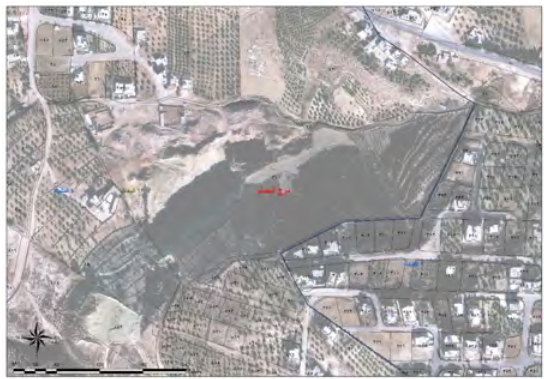
Figure 10. Discontinued quarry site aerial view map. Source: GAM- GIS for the author (2016).